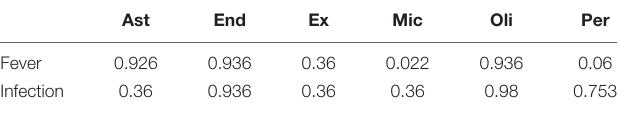
TABLE 1 | P value of cell proportion differential